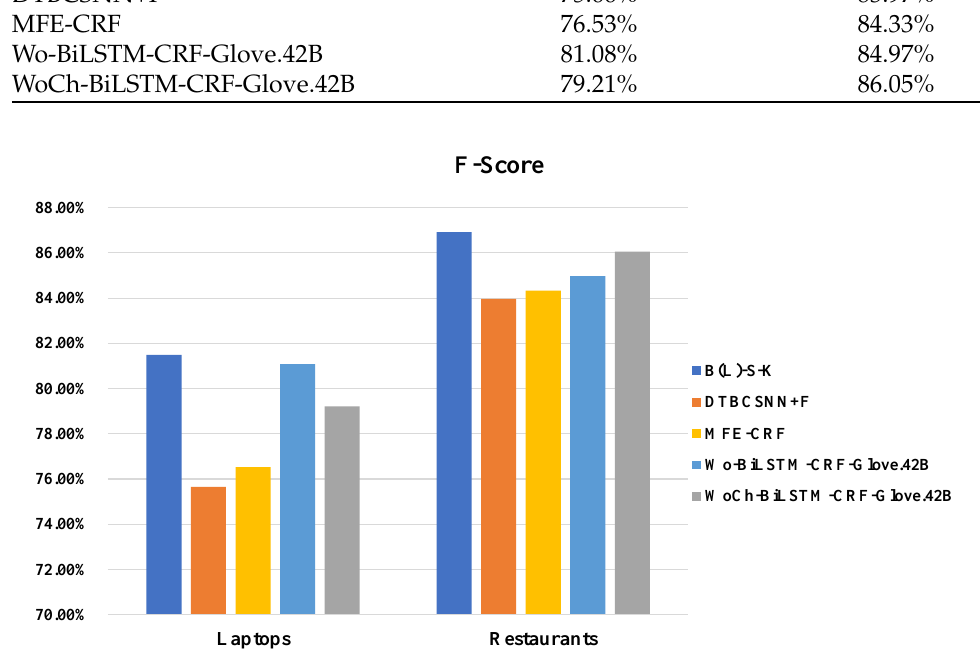
Figure 7. Comparisons of F-score between the baseline methods and our model for the SemEval- 14